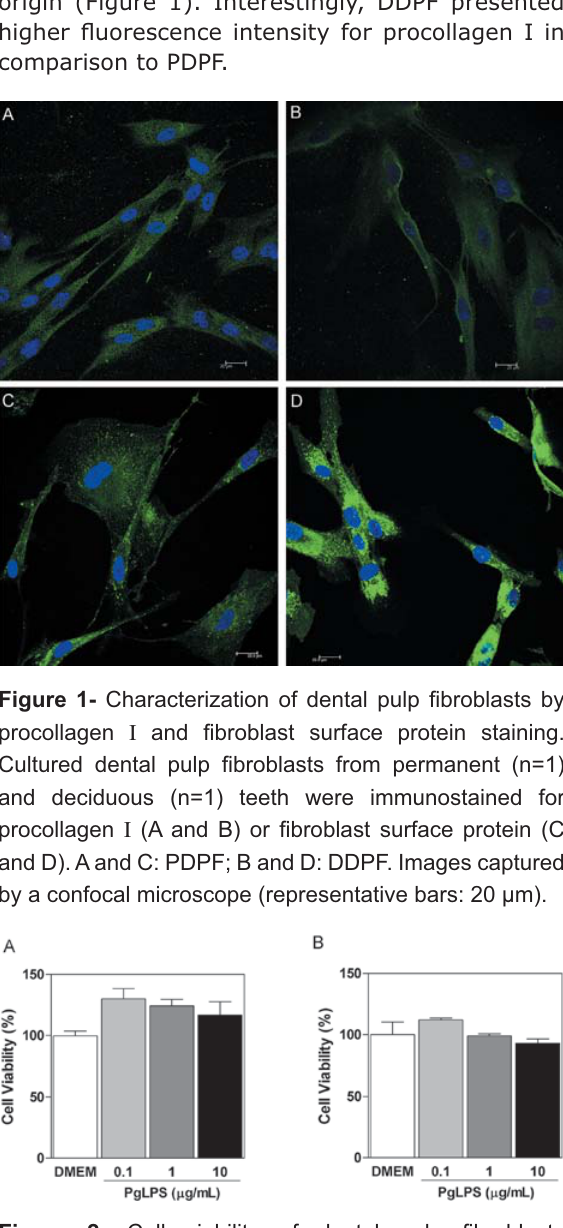
(PgLPS) at the indicated concentrations in triplicate.